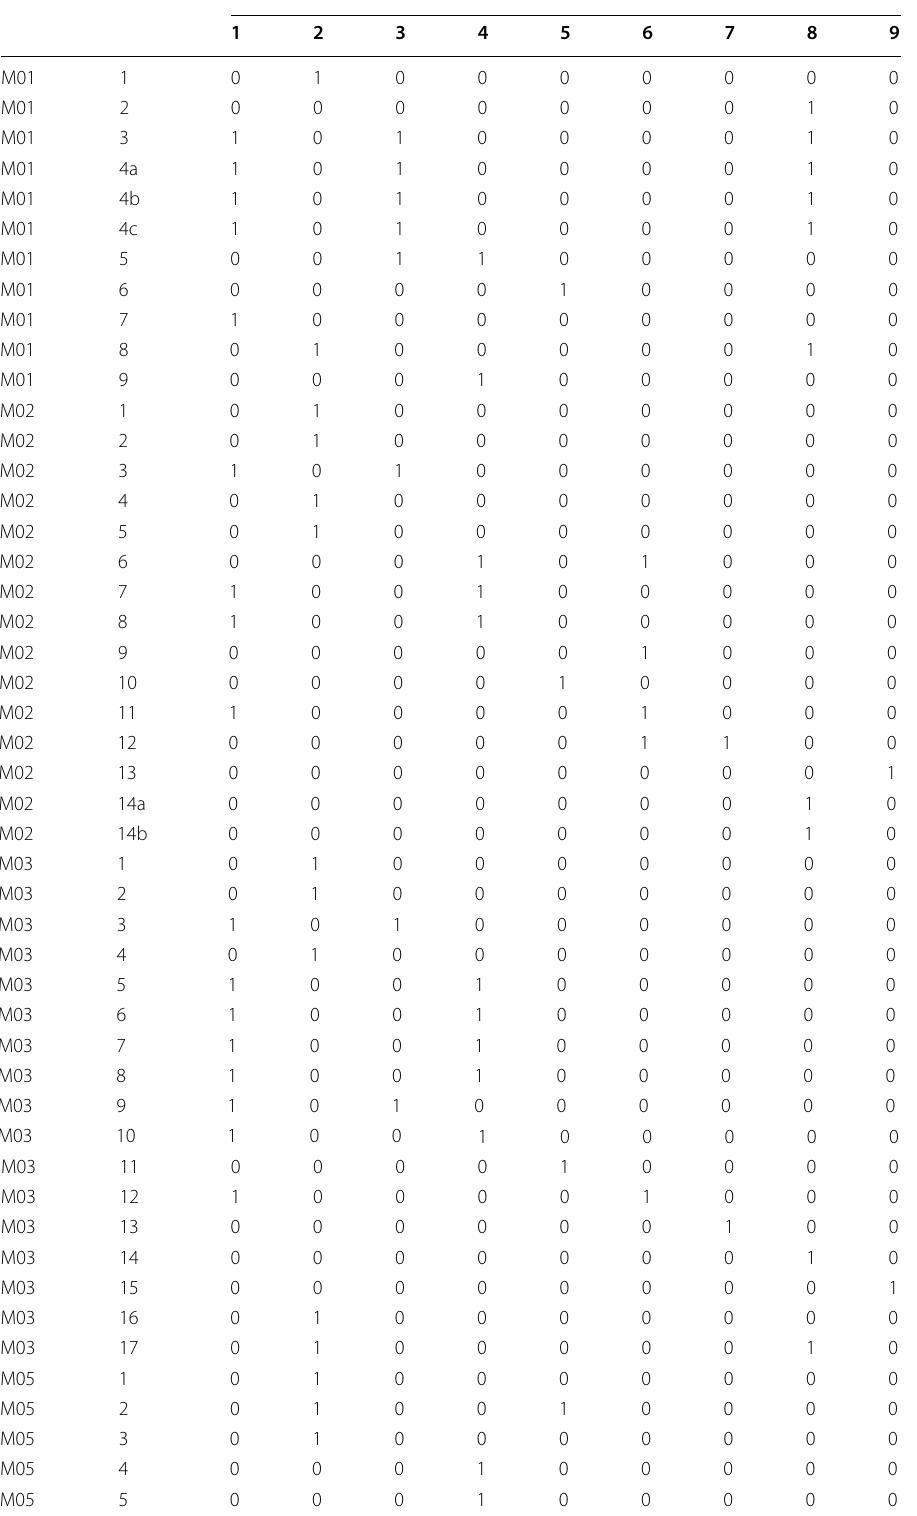
Table 12 Q-matrix refined by the stepwise method: Singapore